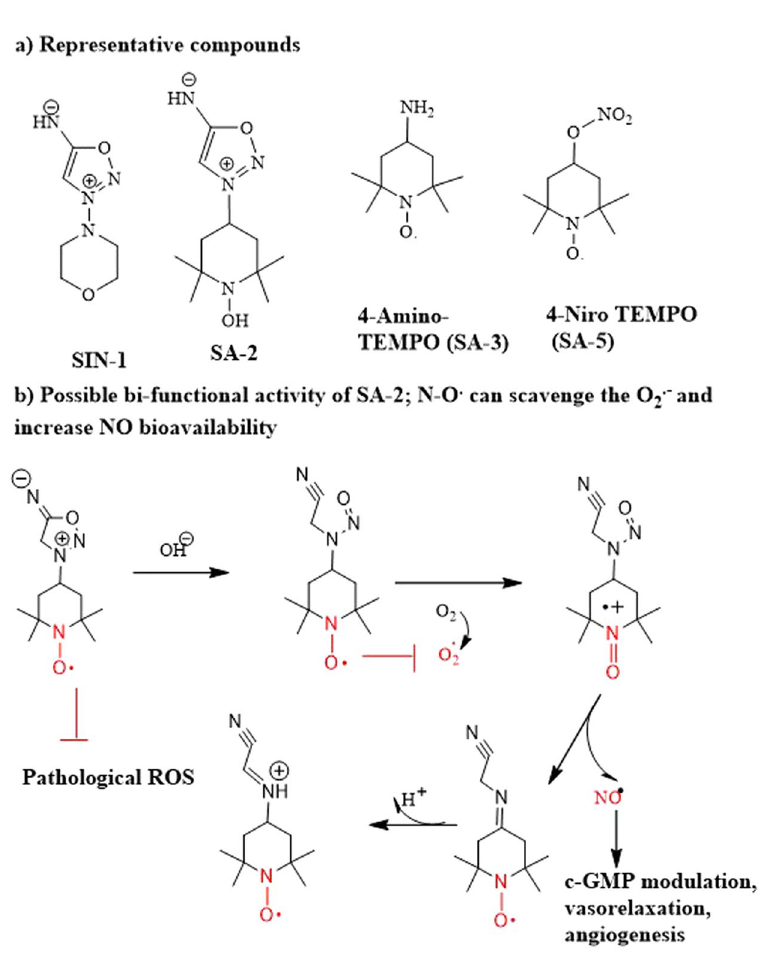
Figure 1. ( a ) SIN-1 (reference NO donor), SA-2 (Hybrid compound), SA-3 (reference antioxidant), SA-5 (reference hybrid NO donor-antioxidant). ( b ) Possible mechanism of synergistic activity of compound